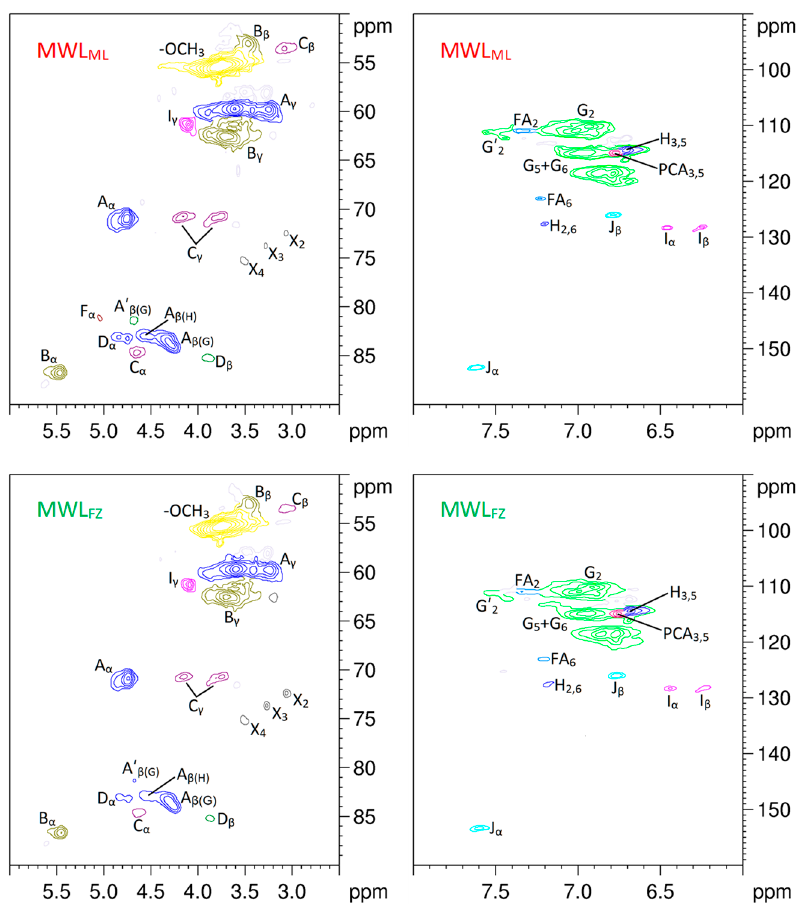
Figure 3. Side-chain ( δ C / δ H 90–50/6.0–2.5) and aromatic ( δ C / δ H 160–90/8.0–6.0) regions of ginkgo shell MWLs in the 2D HSQC NMR spectra.